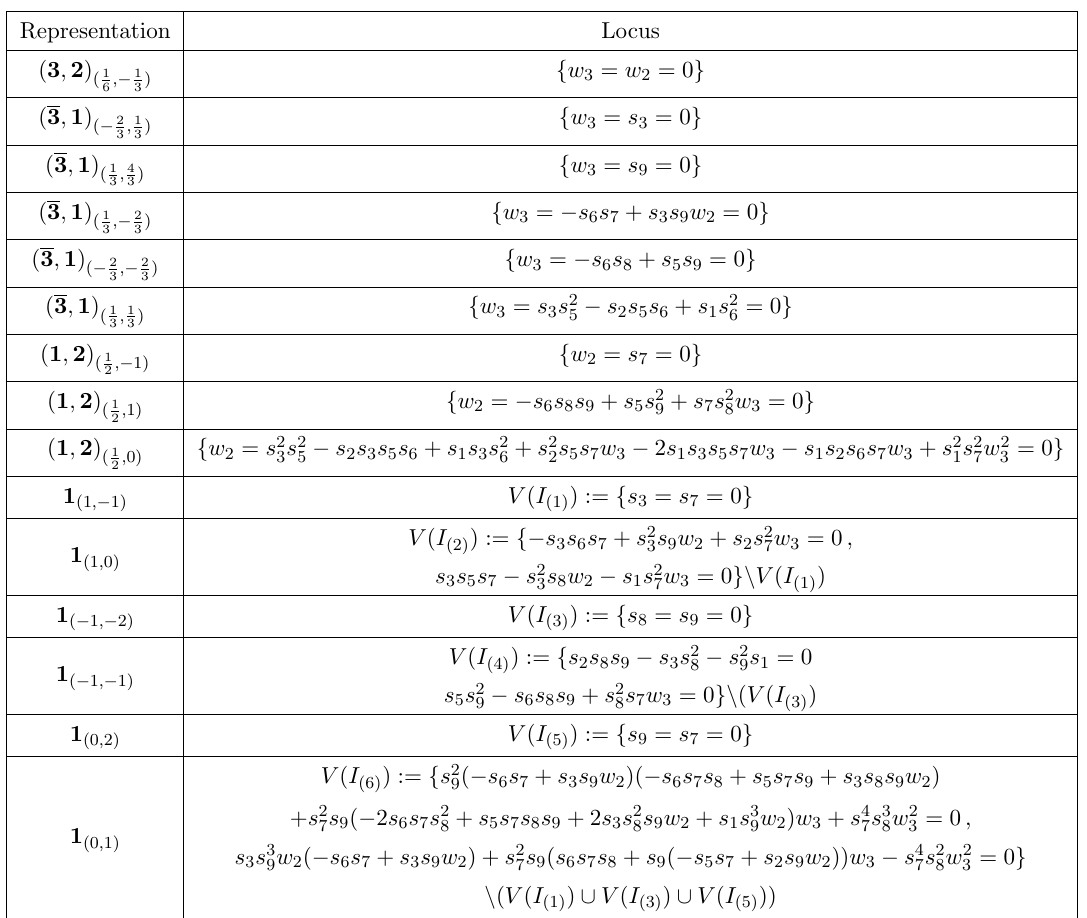
Table 11 . Charged matter under SU(3) (cid:2) SU(2) (cid:2) U(1) 2 with the expressions for their corresponding codimension-two